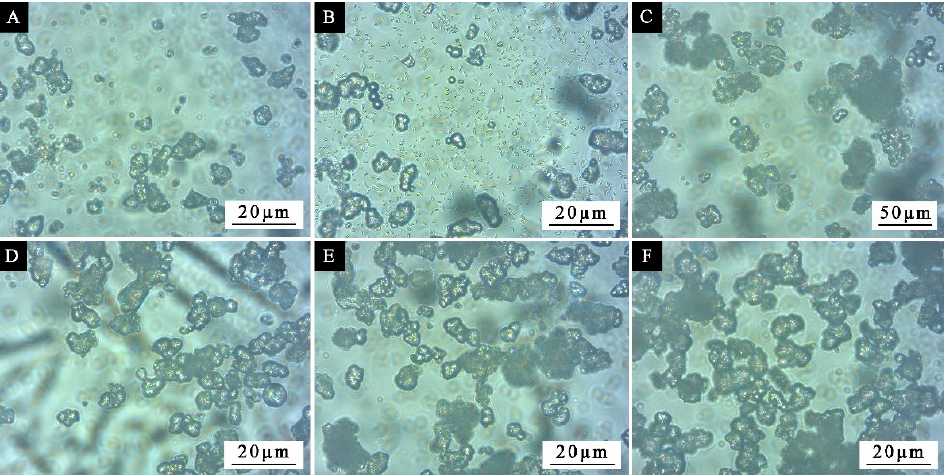
Figure 8. OM morphologies of microcapsules prepared under different depositing time: ( A ) 0, ( B ) 1 d,